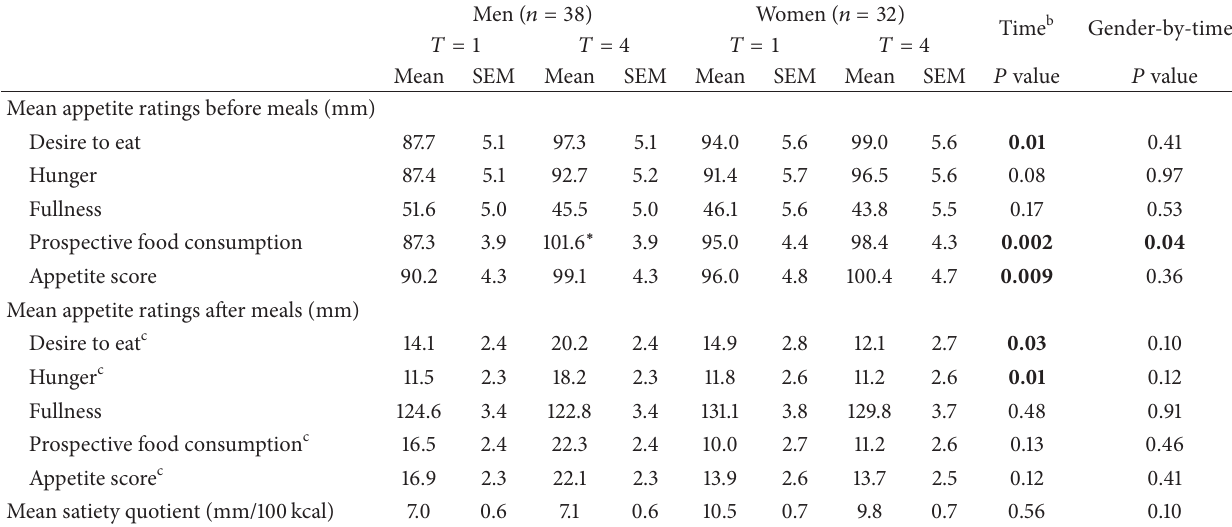
Mean satiety quotient (mm/100kcal)